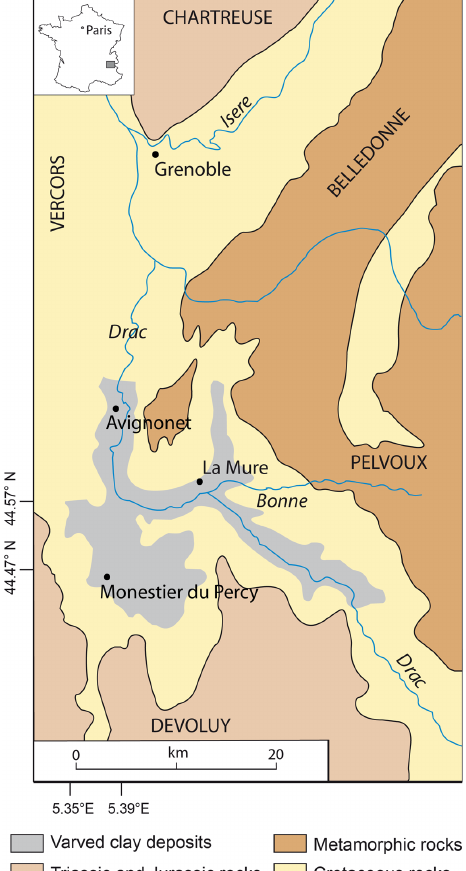
Fig. 1. Geology of the Tri`eves area and locations of landslides used in this